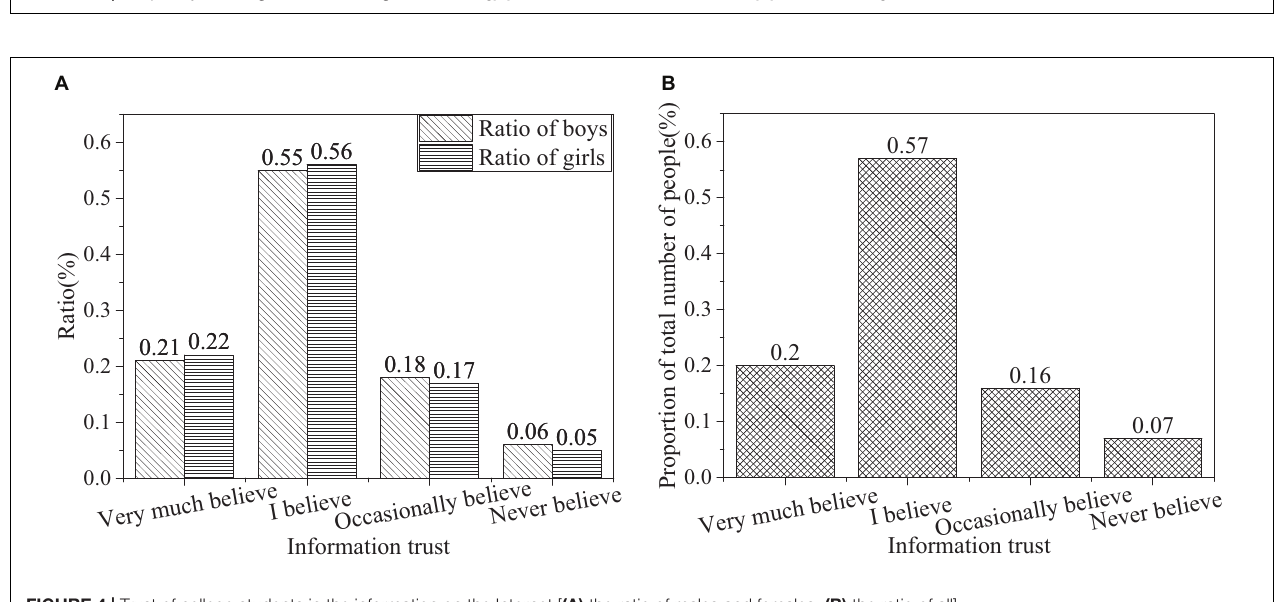
FIGURE 4 | Trust of college students in the information on the Internet [ (A) the ratio of males and females; (B) the ratio of